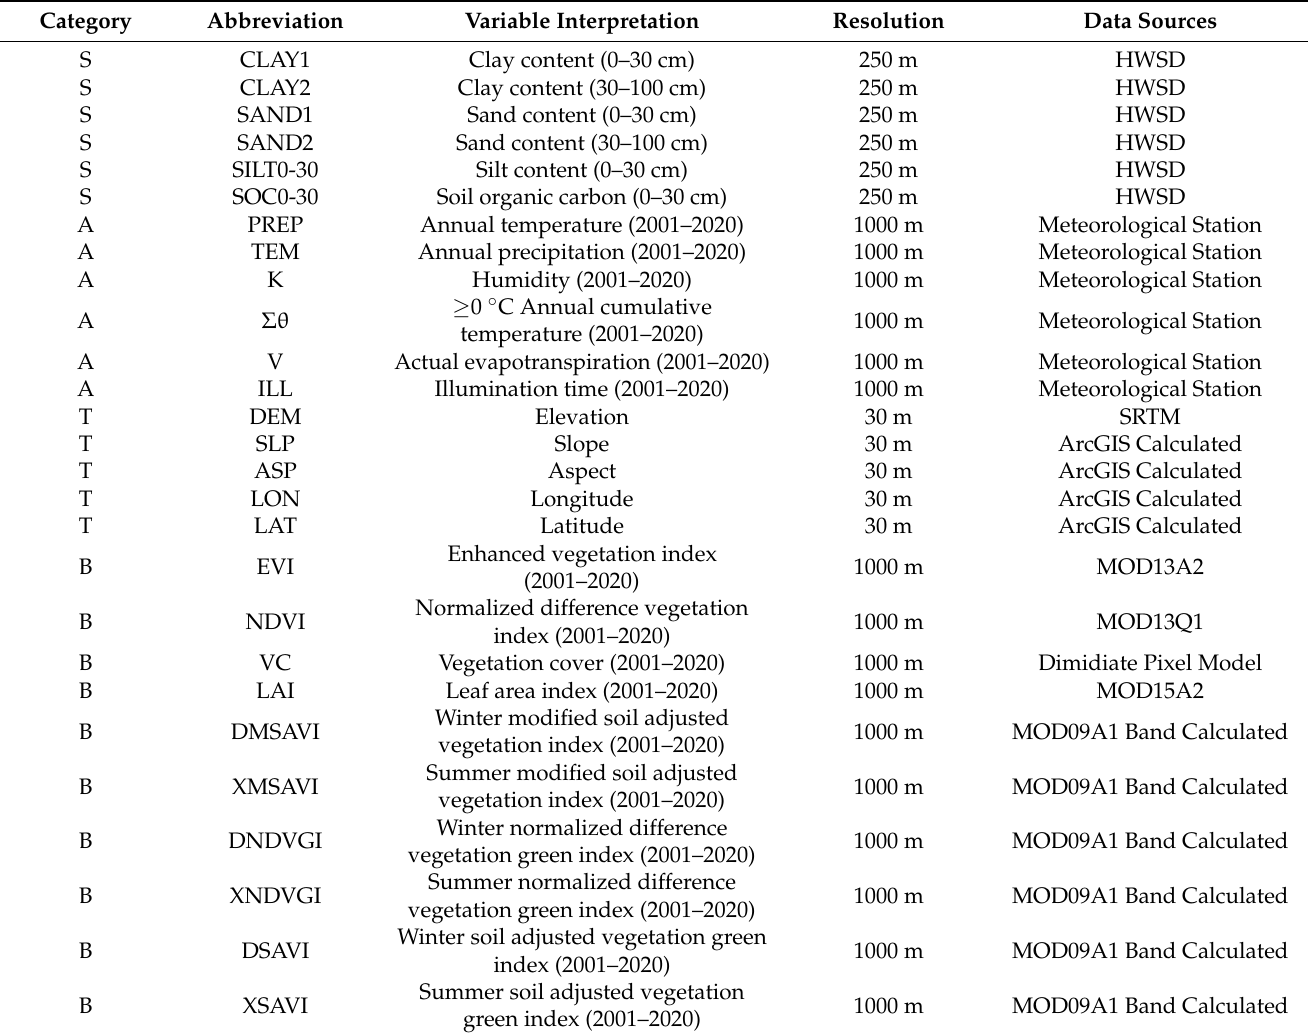
Table 1. All environment variables and data